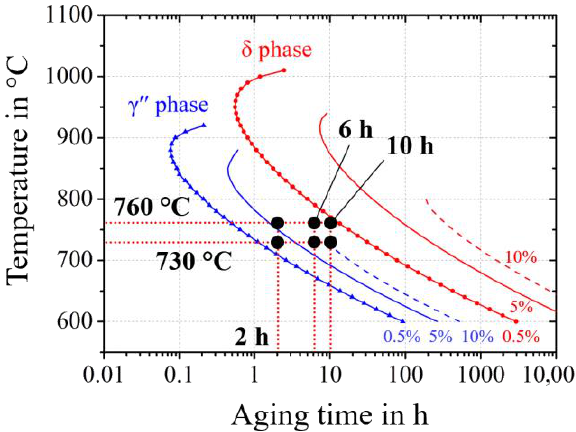
Figure 3. Calculated Time Temperature Transformation (TTT) diagram of the alloy 718M. The curves represent the time passed until 0.5%, 5% and 10% of equilibrium 12 wt.% of γ′′ or stable δ phase. Aging treatments with six different temperature–time combinations are carried out.